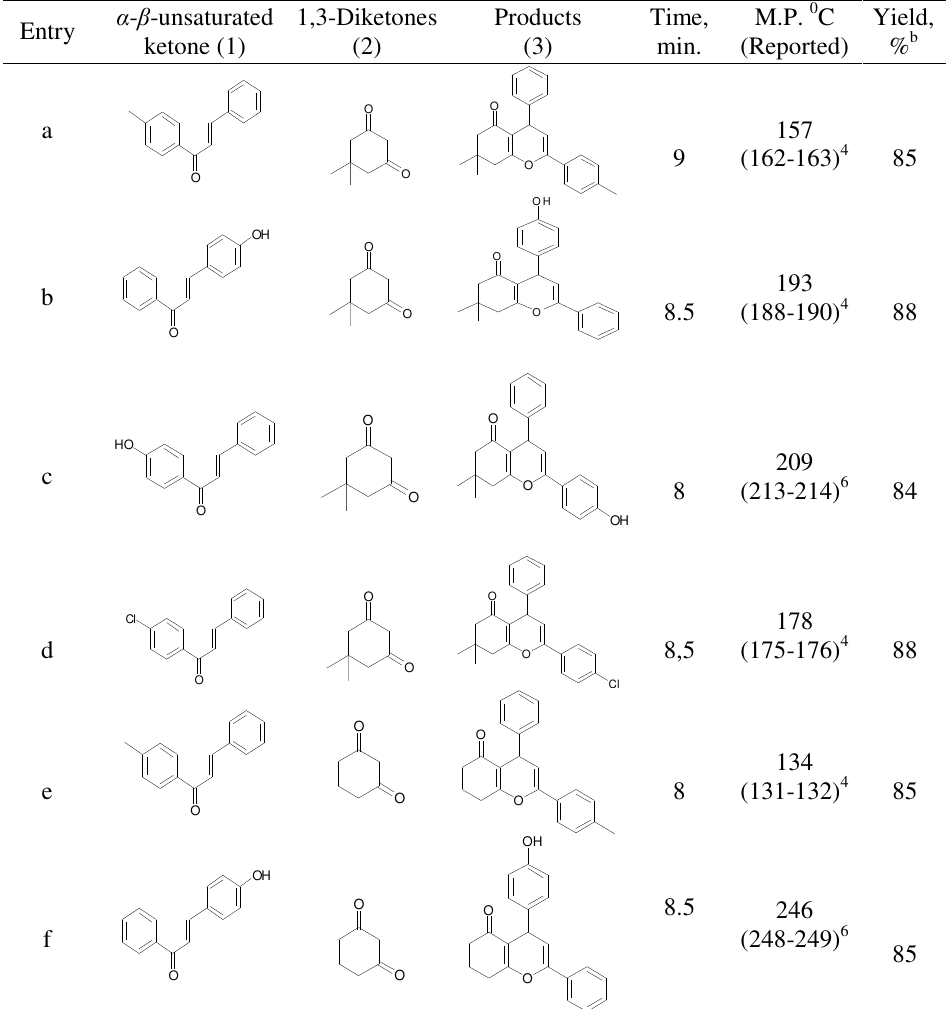
Table 1 . Synthesis of 2,4-diphenyl-4H-chromen-5-one catalyzed by ZnCl montmorillonite K -